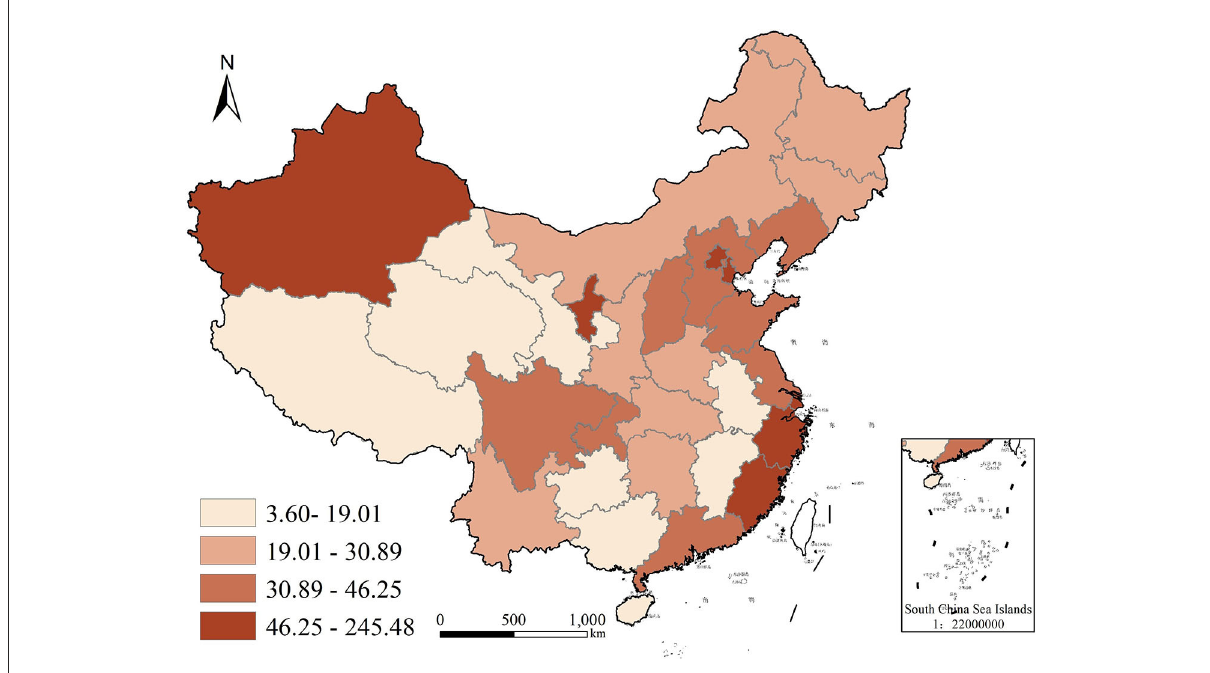
FIGURE2 Commercial health insurance density in China in 2009.